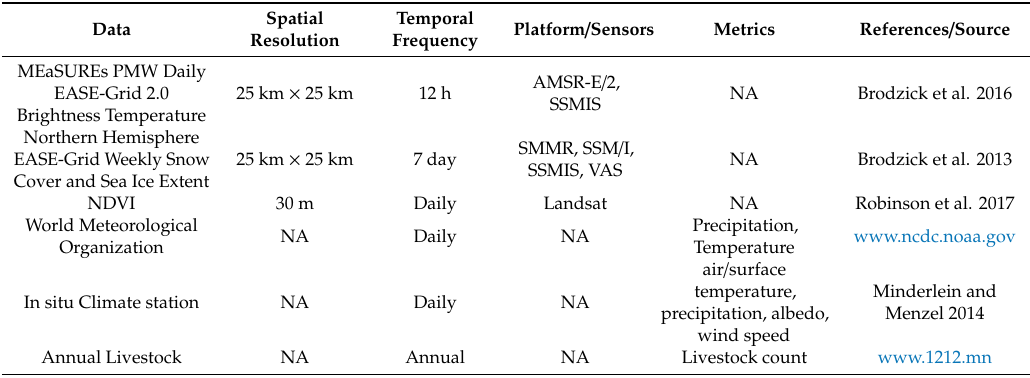
Table 1. Summary of datasets used in this